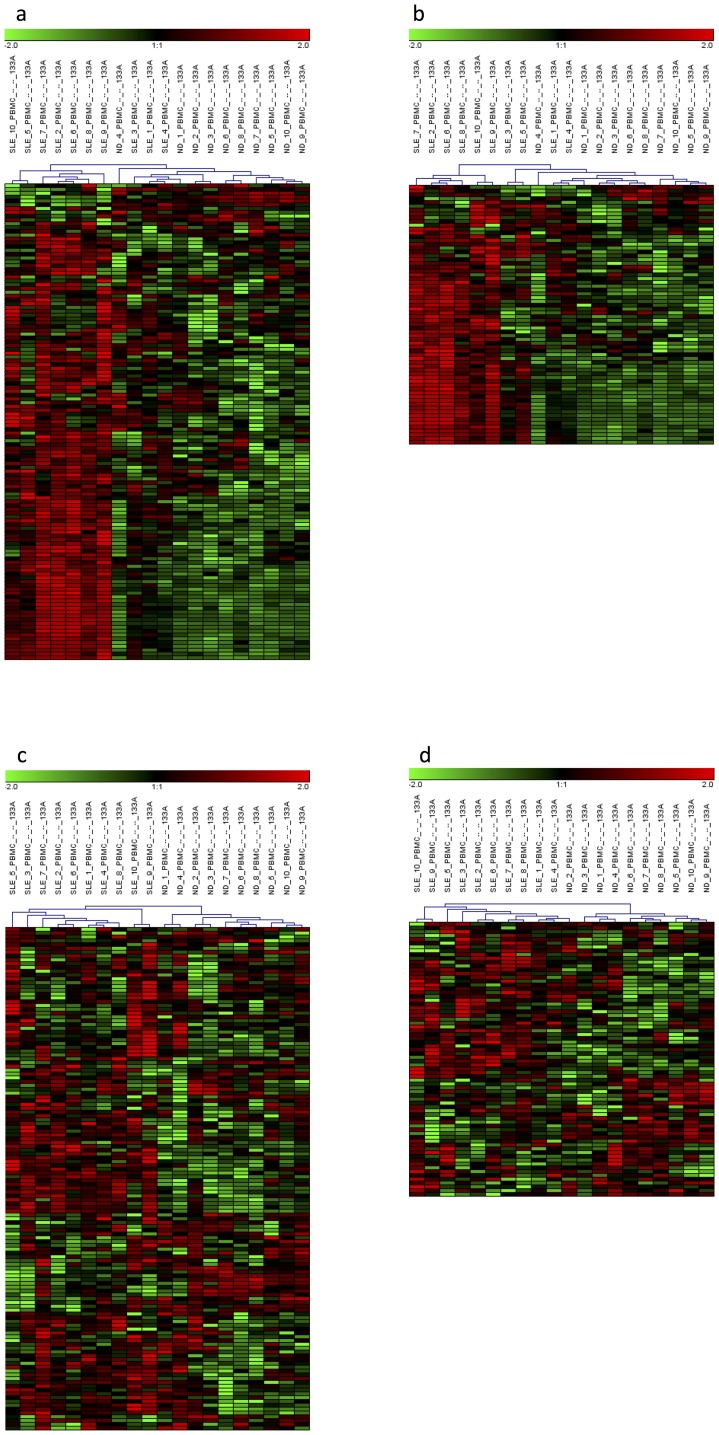
For the validation of the 125 monocyte- (a) and the 68 T helper lymphocyte-specific (b) common-IFN signature genes their expression were followed in PBMC's of an independent cohort of juvenile SLE patients.In addition, we used these samples to validate the 132 monocyte- (c) and the 72 T helper cell-specific (d) gene signatures, which have been identified as autoimmune-specific type I IFN response signatures in these cell types. The common IFN signatures of both cell types allowed a correct classification in 8 out of 10 samples. Only the autoimmune-specific IFN signature of monocytes allowed a correct grouping of all SLE samples.